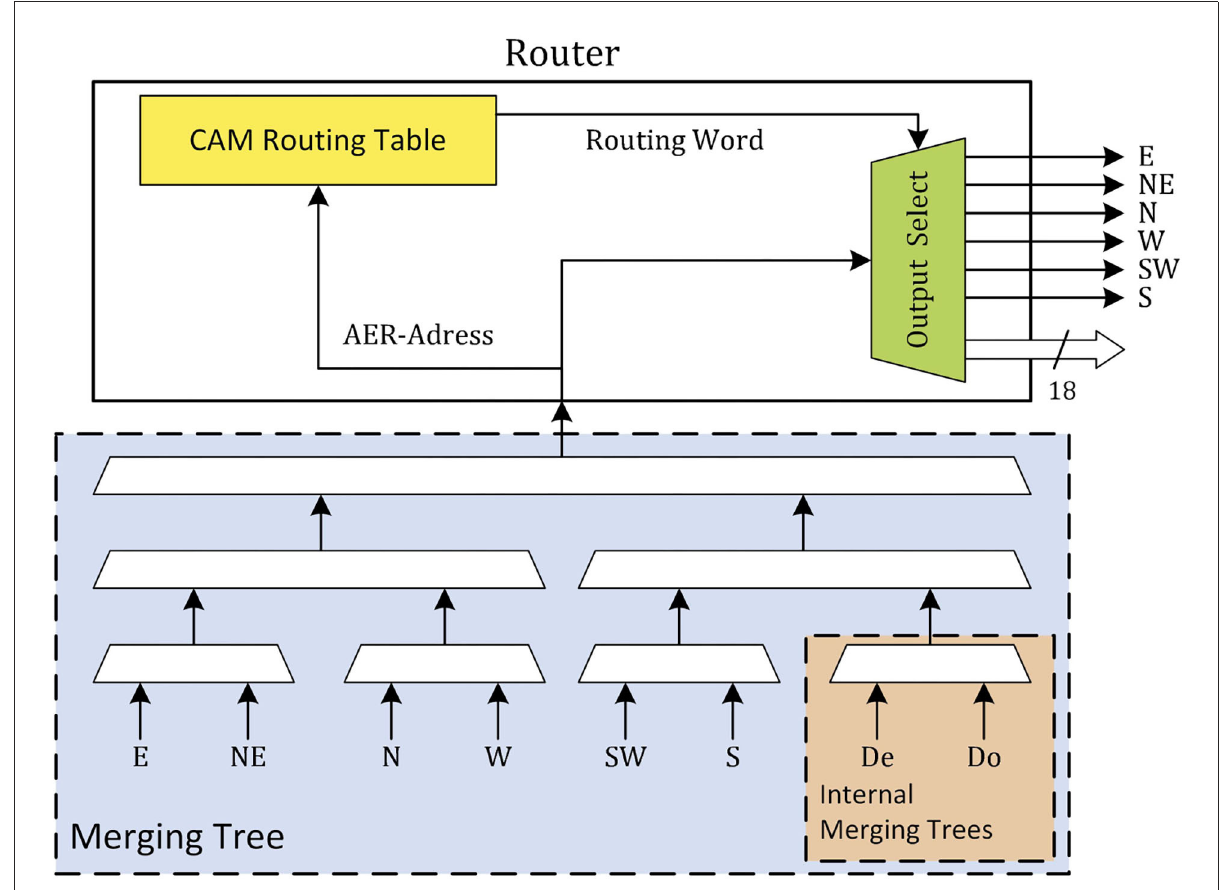
FIGURE1 Role of merging trees in the SpiNNaker